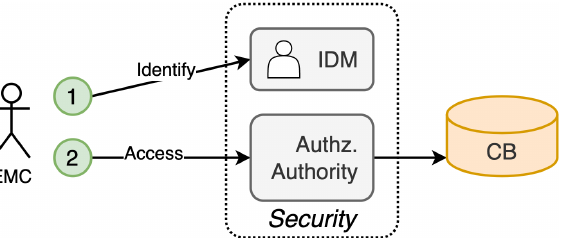
Figure 15. Secure access of Energy Management Components to the Context